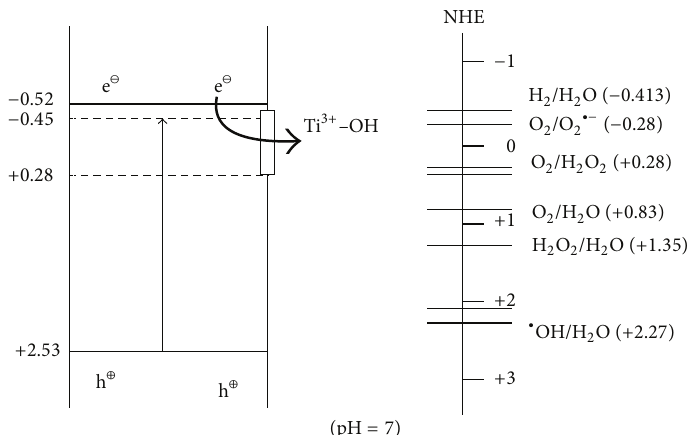
Figure 3: Schematic of photogenerating initial oxidizing agents on the TiO 2 surface in the presence of electron-donor (D) and electron- acceptor (A)